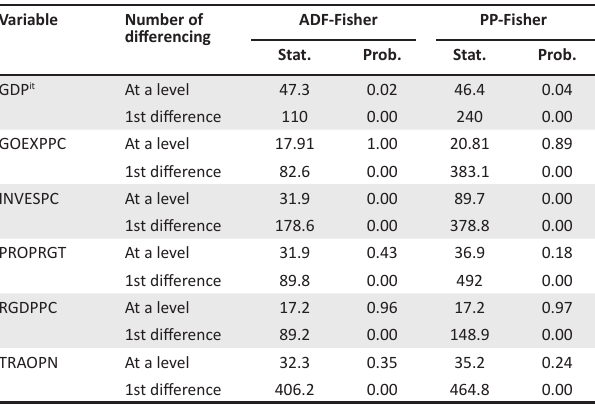
TABLE 2: Unit root test.